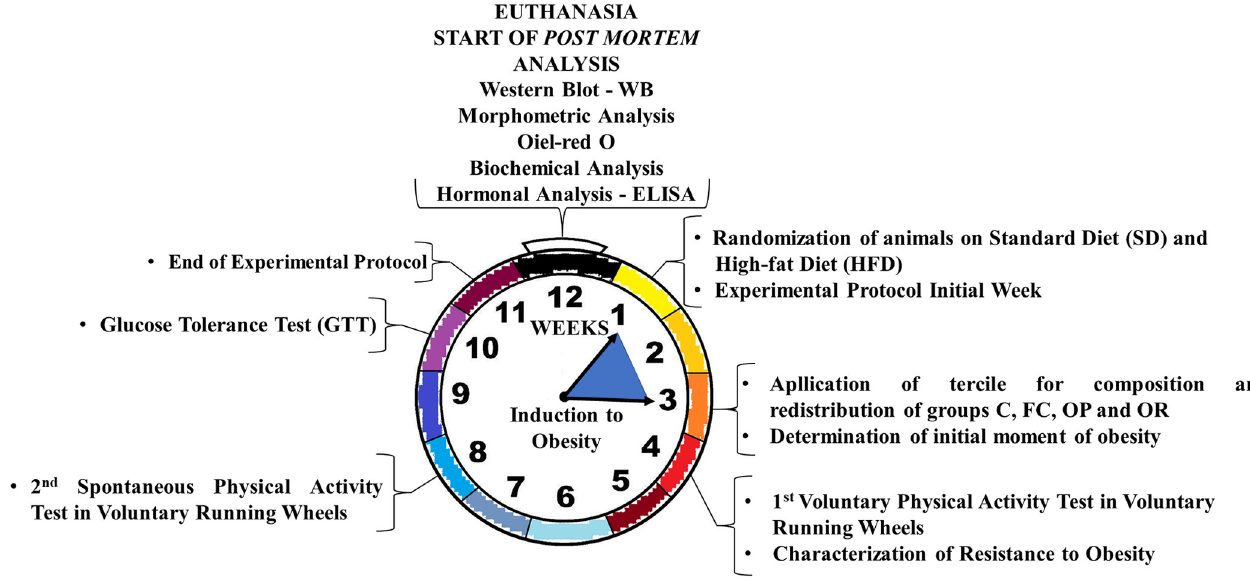
Fig 1. Schematic representation of the experimental protocol (12 weeks; in vivo as well as post mortem analyses).